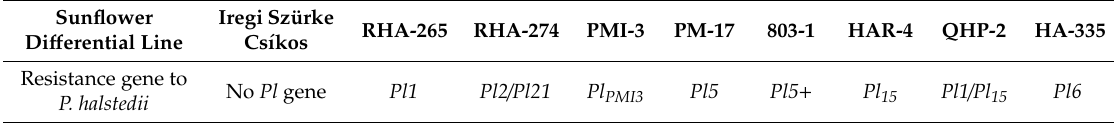
Table 4. Sunflower di ff erential lines used for pathotype identification for P. halstedii in the experiment and resistance genes incorporated (based on Gascuel et al.